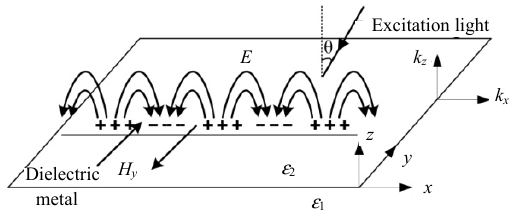
Fig. 1 Schematic illustration of SPPs at a metal-dielectric